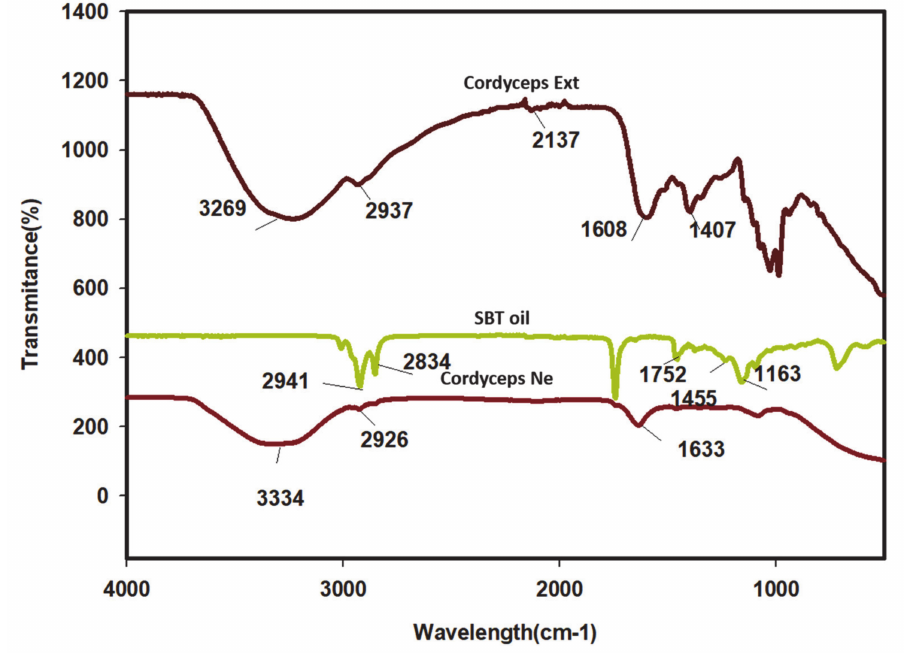
Figure 1. FT-IR analysis for Cordyceps nanoemulsion with Cordyceps extract (COR-Ex) and sea buckthorn